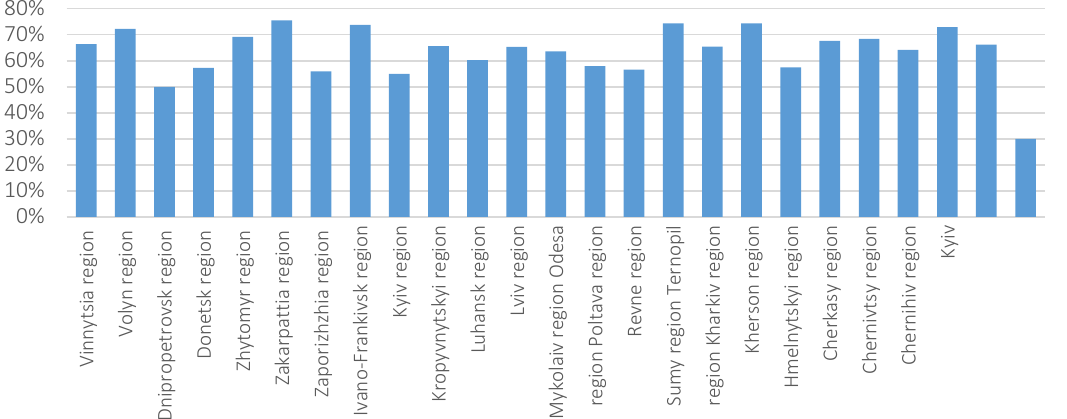
Figure 4. The share of transfers in local budget revenues of Ukraine in